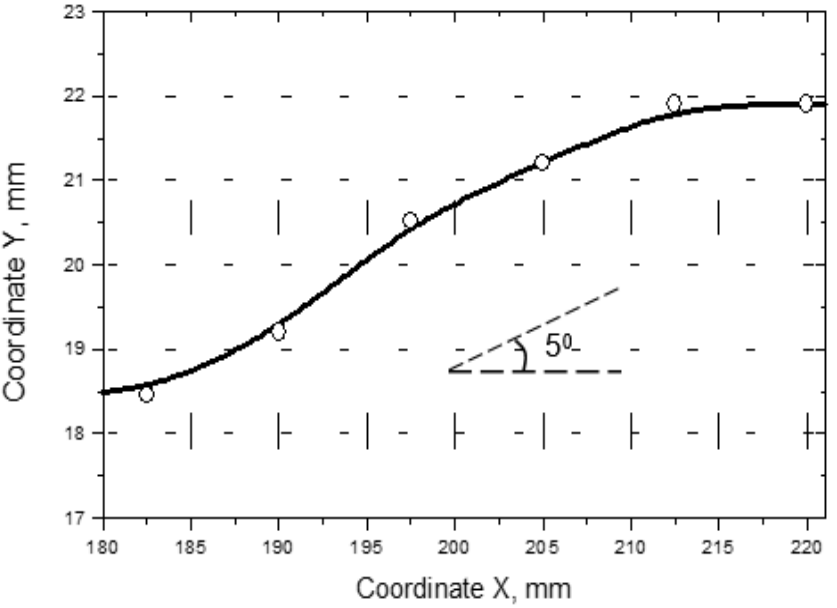
Figure 26. Reconstruction of fibre trajectory in a 5° in-plane undulation area of a CFRP specimen. In multiply composites, a similar experiment identifies a major reinforcement direction which is caused by various fibre orientations in lay-up stacks. To identify the fibre lay- ups involved the measured polarization velocity curves have to be examined against the simulation results for reference composite structures. The latter can be obtained by using the analytical partial wave approach (Section 3.2) or the MatLab calculations of successive reflections/transmissions at the interfaces between the plies [33]. The minimum difference between the measured and the simulated results indicate a close equivalence of the multiply composite studied to the reference arrangement.